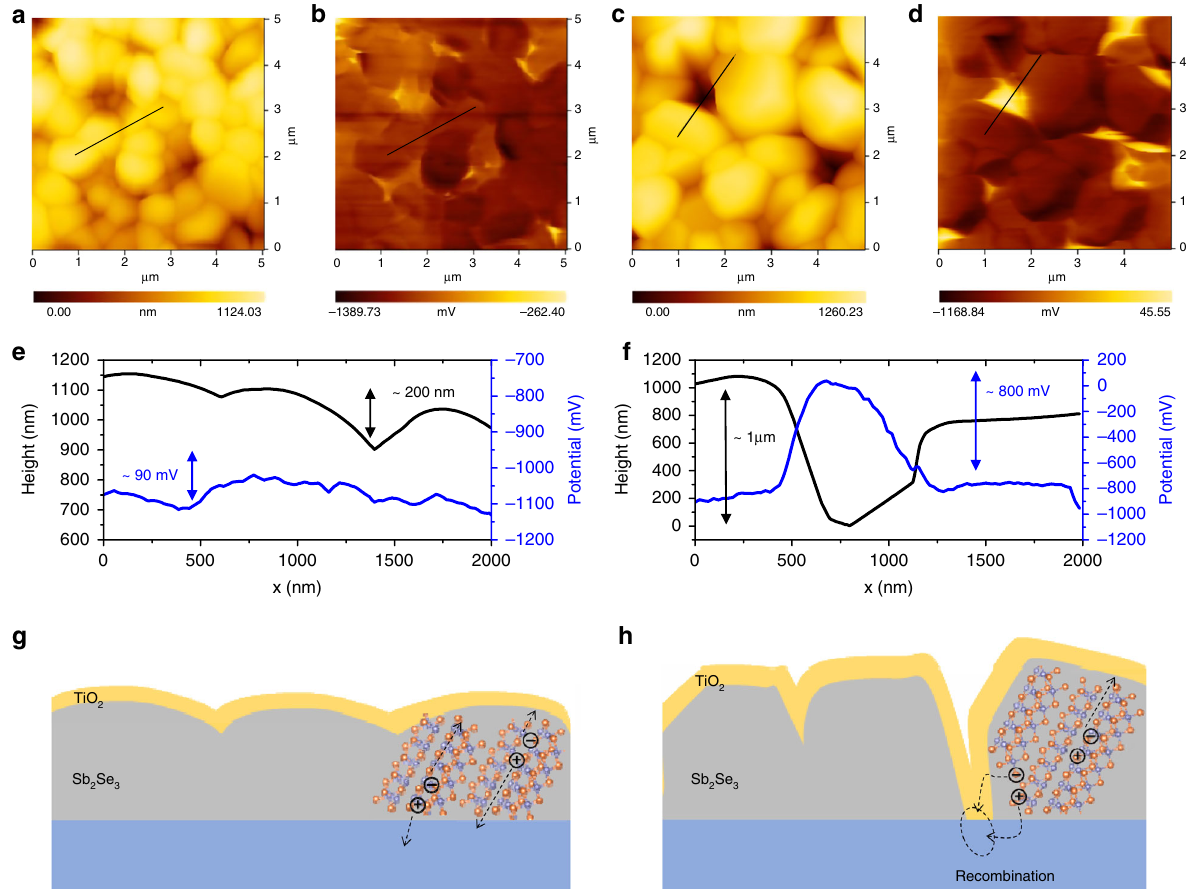
Fig. 3 Topography and surface potential of TiO 2 /Sb 2 Se 3 according to KPFM analysis. a , c Topography of a fast- and c slow-cooling samples. b , d Surface potential of b fast- and d slow-cooling samples. e , f Topography and potential line pro fi le (obtained from scanning the black lines in Fig. 3a – d) for e fast- and f slow-cooling samples. g , h Schematics showing possible charge separation and recombination in g fast- and h slow-cooling samples. Source data used to generate this fi gure can be found in the Source Data fi